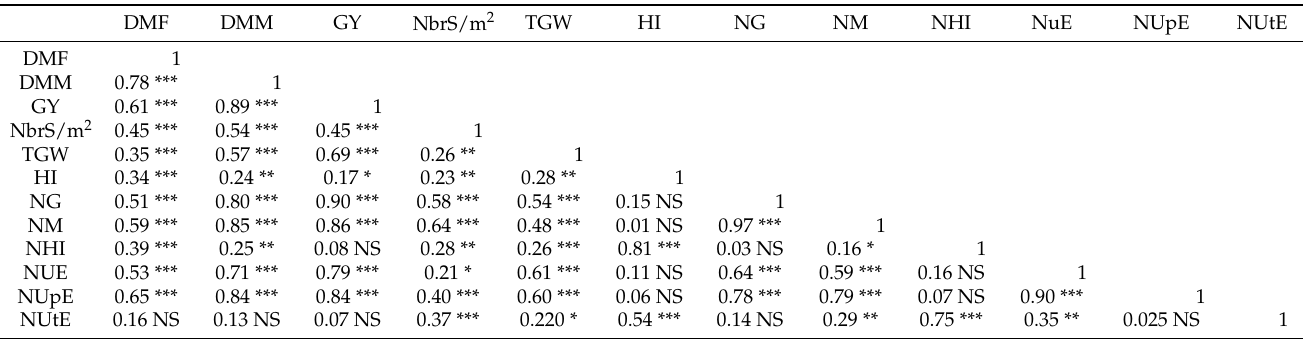
Table 6. Relationships between NUE and its components with dry matter, grain yield, and its